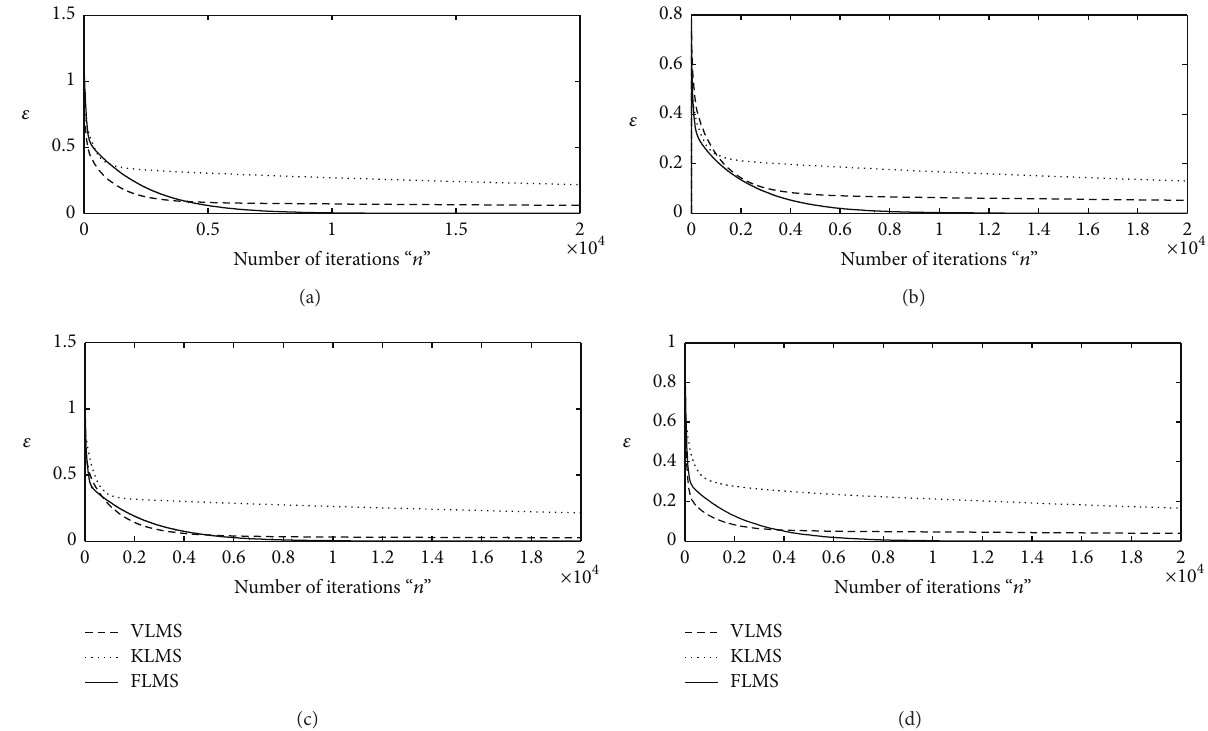
Figure 4: Iterative adaptation of merit function by VLMS, KLMS, and FLMS for fr = 0.5 algorithm for 𝜇 ∈ (10 −04 , 10 −08 ); (a) for SNR = 30 dB, (b) for SNR = 20dB, (c) for SNR = 10, and (d) for SNR =